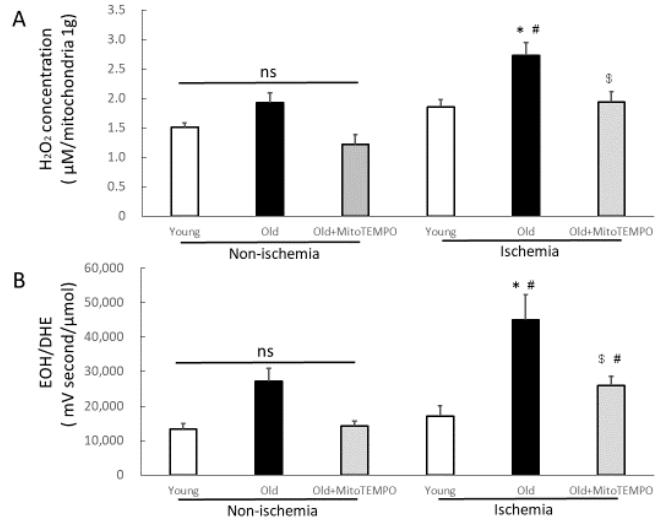
Figure 1. Effect of MitoTEMPO on mitochondrial H 2 O 2 and superoxide in tissue extracts of ischemic skeletal muscle. The mitochondrial H 2 O 2 concentration was measured in non-ischemic and ischemic (post-operative day (POD) 2) skeletal muscle from young, old, and MitoTEMPO-treated old mice ( A ); the levels of superoxide in tissue extracts were determined by the ultra-performance liquid chromatography (UPLC) method ( B ). The levels of mitochondrial H 2 O 2 and superoxide in tissue extracts under ischemic conditions were higher in old mice than in young mice from the ischemic group. MitoTEMPO treatment decreased the levels of mitochondrial H 2 O 2 and superoxide in tissues to levels of young mice. The values are expressed as the means ± S.E.M. n = 10, each. * p < 0.05 vs. young mice, $ p < 0.05 vs. old mice, # p < 0.05 vs. non-ischemic skeletal muscle. ns indicates no significant difference.